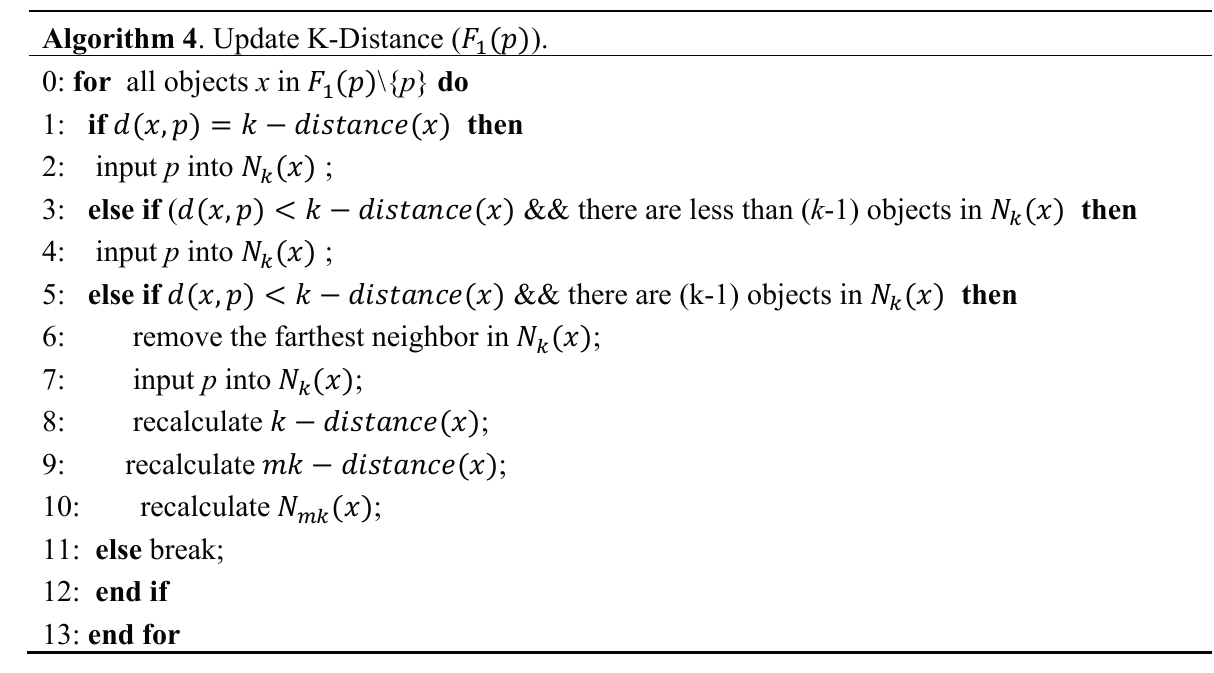
Algorithm 4 . Update K-Distance ( (cid:1832)